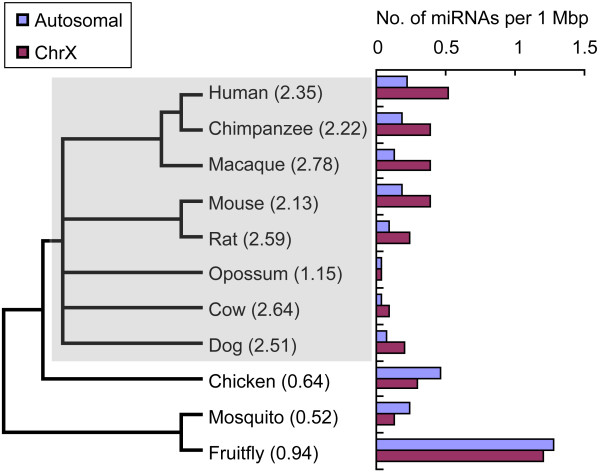
Density distribution of miRNAs across chromosomes among species. Densities of miRNAs on the X chromosome and autosomes are shown for different species, except for chicken, where the Z chromosome is used instead of X. Densities are shown as number of miRNAs per megabase of DNA. The ratios of densities between the X chromosome and autosomes are shown in brackets. Mammals in the species tree on the left are shaded in grey.